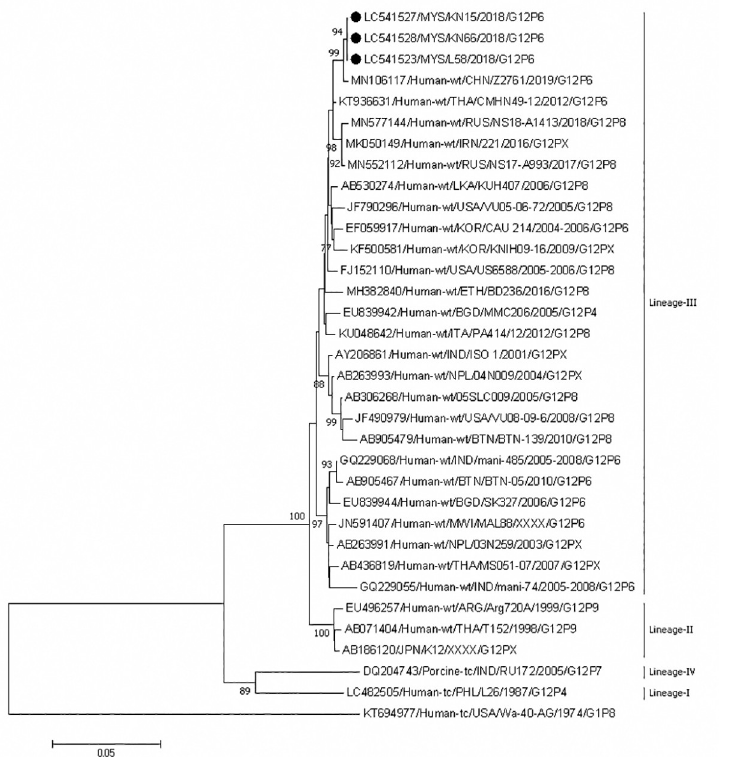
Fig 4. Phylogenetic tree constructed with the nucleotide sequences of the VP7 gene of G12 strains. Human rotavirus Wa-40-AG (G1) was used as an outgroup. The number adjacent to the node represents the bootstrap value and values lower than 70% have not been indicated. Scale bar shows genetic distance expressed as nucleotide substitutions per site. The strains identified in this study are marked with a filled circle. Strains from Sabah belong to lineage III. The nucleotide sequences of our strains have been submitted to the databases of the DNA DataBank of Japan, the European Molecular Biology Laboratory, and GenBank. The accession numbers are shown at the beginning of each